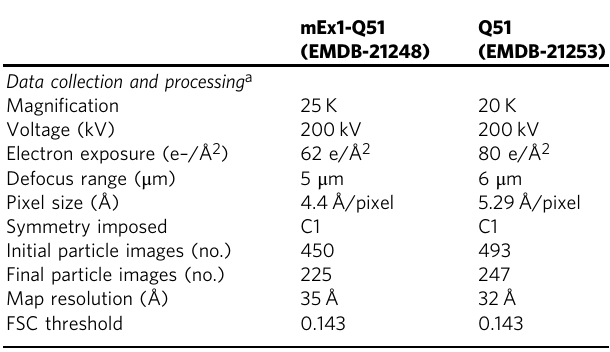
Table 1 Cryo-EM data collection, re fi nement and validation